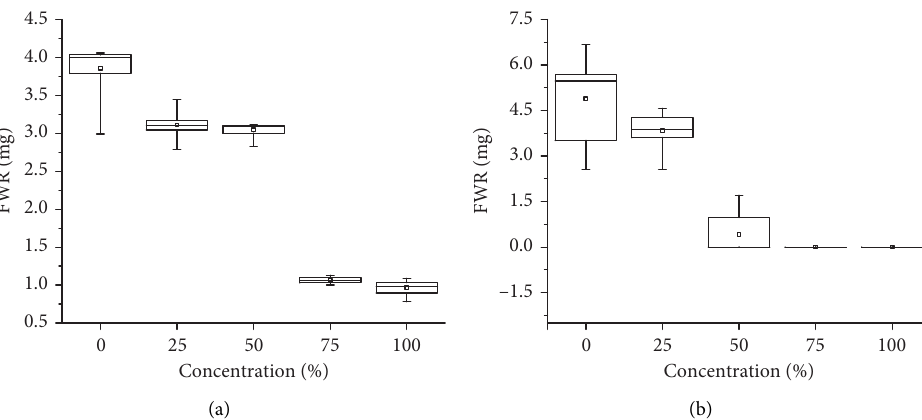
Figure 7: Fresh weight of root (FWR) of germinated P. vulgaris (a) and O. sativa (b) seedlings in screen house experiment after 7 and 14 days of treatment with S. suaveolens extracts, respectively.